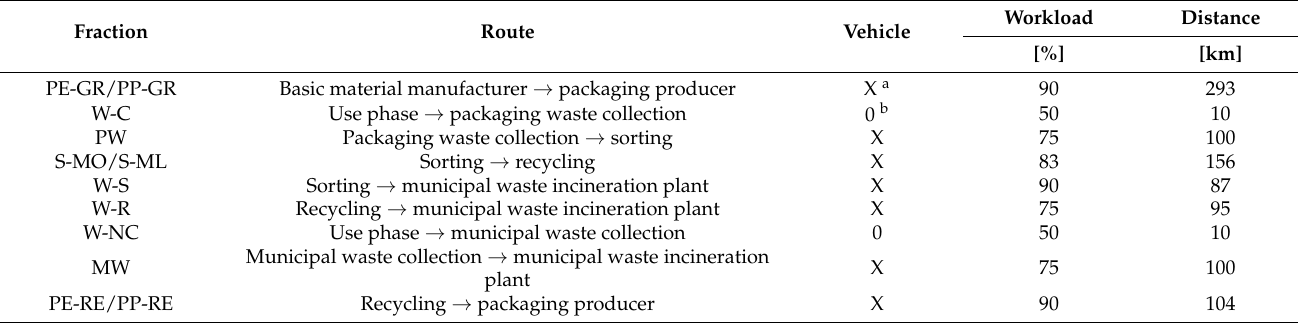
Table 8. Specific transport distances, utilisation rates and